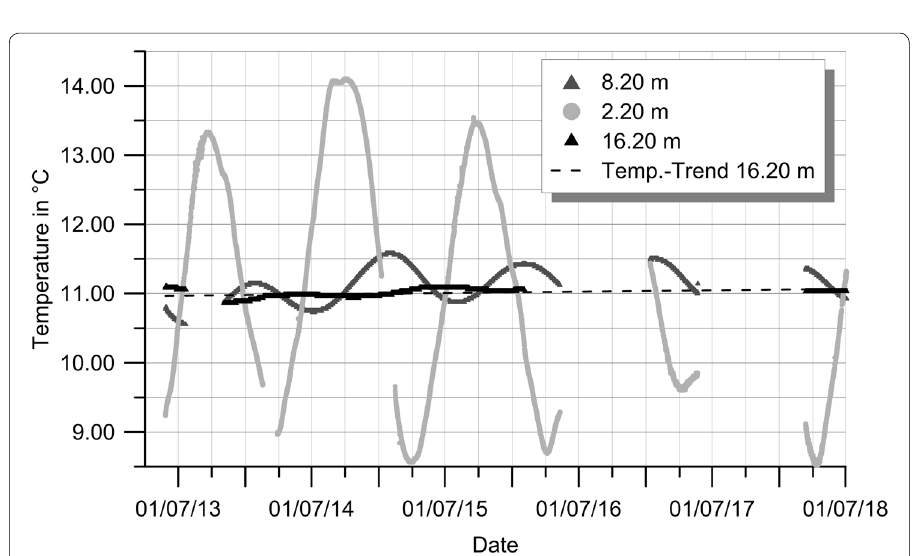
Fig. 4 Overview of soil temperature development in selected depths at well location